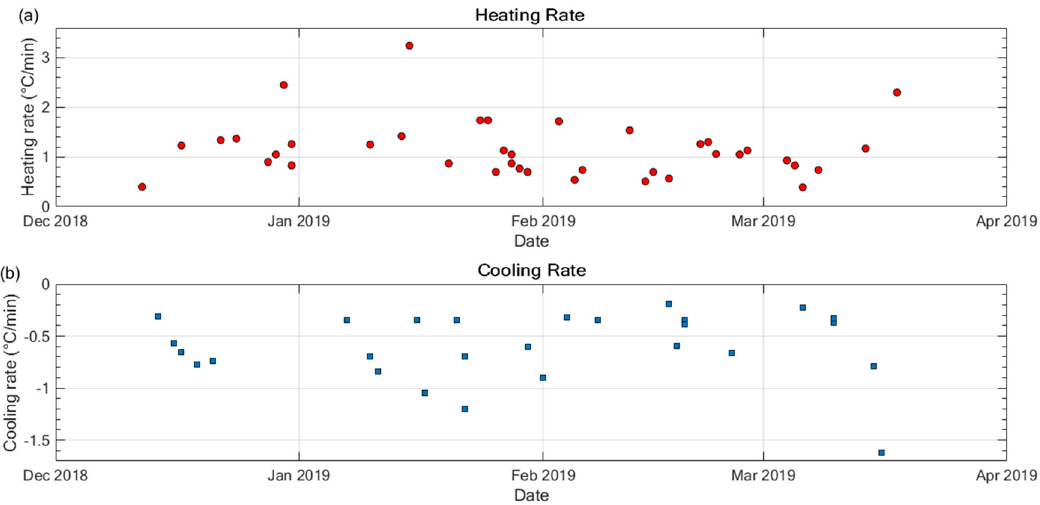
Figure 15. Heating and cooling rates for MM samples between December 2018 and March 2019. ( a ) Heating rate; ( b ) cooling rate.